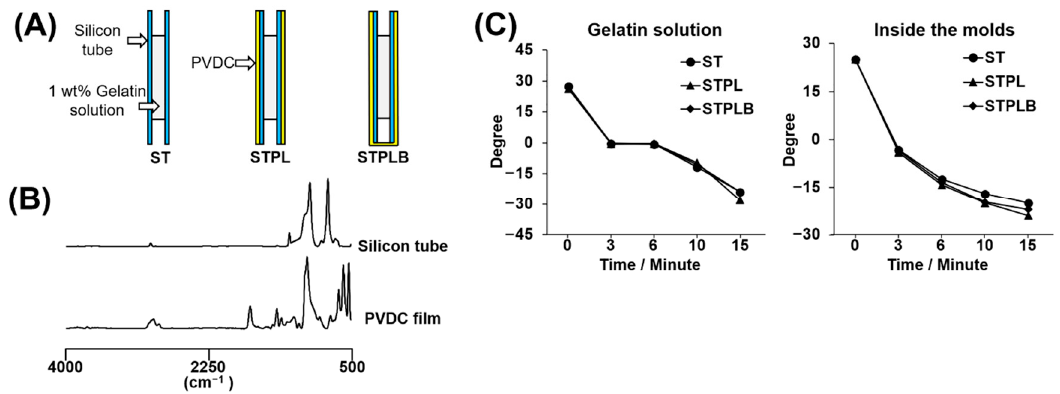
Figure 1. ( A ) Schematic images of three types of molds. ST: silicon tube showing high permeability; STPL: ST covered with polyvinylidene chloride (PVDC) at the lateral side; STPLB: ST covered with PVDC at the lateral and bottom sides. ( B ) Spectra of attenuated total reflection–Fourier transform infrared (ATR–FTIR) analysis on the silicon tube and the PVDC-contained film. ( C ) Temperature variation of gelatin solutions in molds or temperature variation inside of molds during prefreezing.